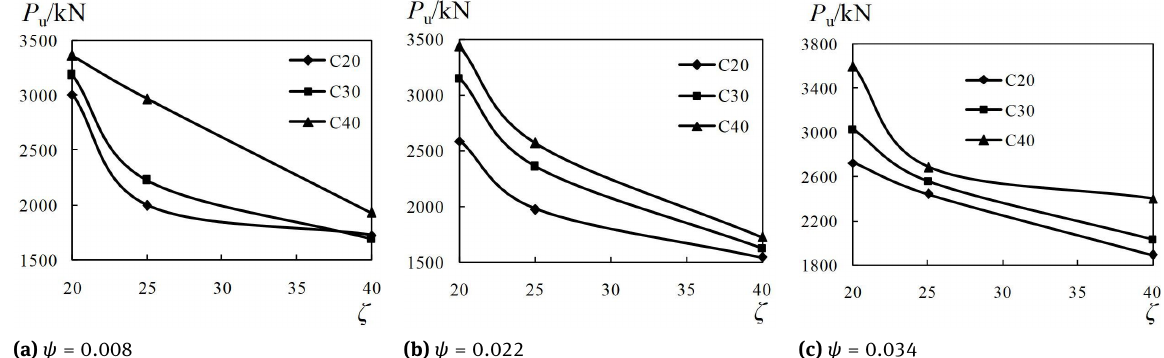
Figure 15: Ultimate load versus diameter-thickness ratio of GFRP tube curves